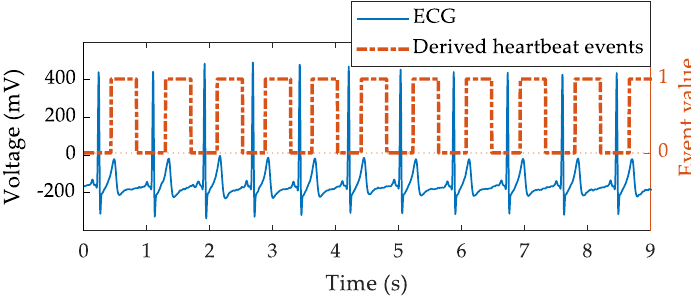
Figure 4. Reference ECG signal (ECG) and the binarized target signal (derived heartbeat events) where the values of “1” represent the presence of the mechanical heart displacement after the R wave, and the values of “0” represent its absence.